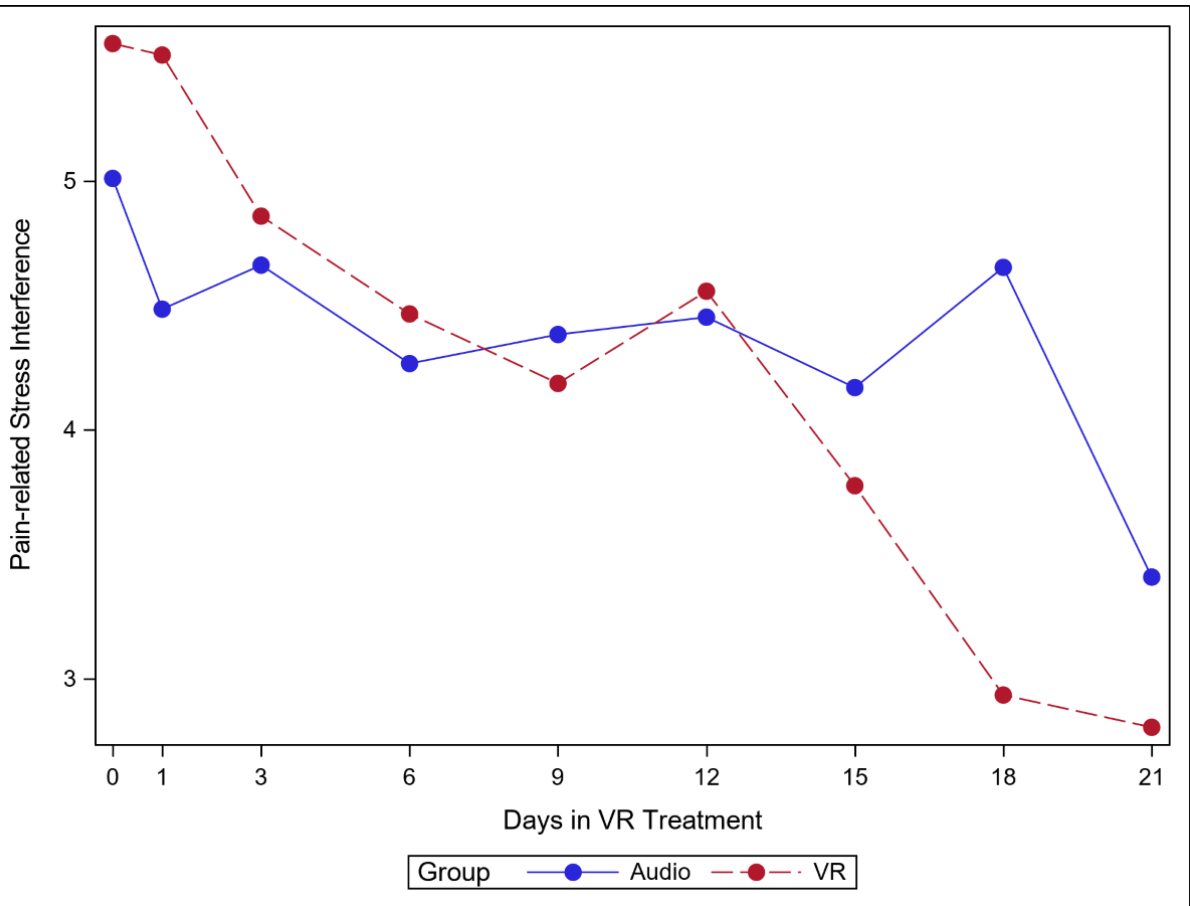
Figure 8. Effect of virtual reality vs audio on pain-related stress interference over